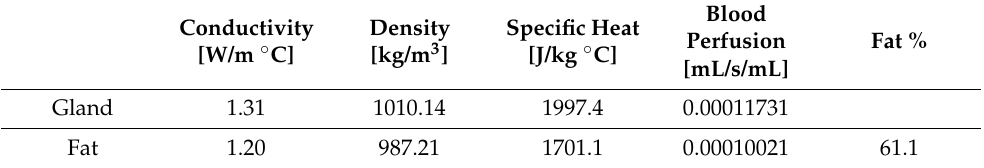
Table 10. Estimated specific breast parameters (patient #4).